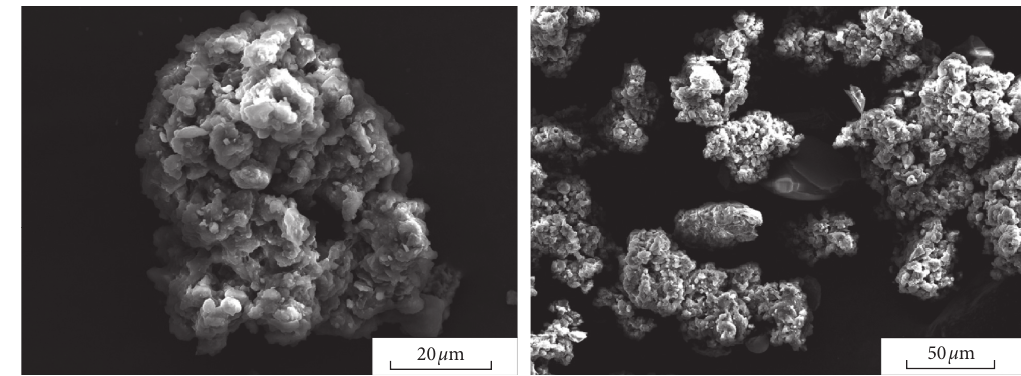
Figure 1: SEM of the rubber powder. Table 4: Mix proportions of specimens.